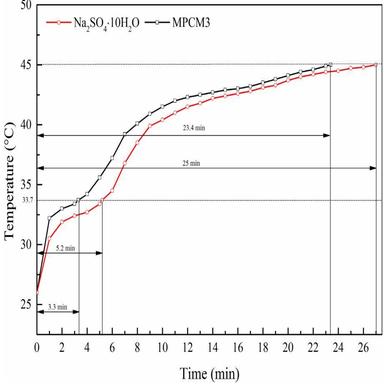
The temperature curves of the Na2SO4·10H2O and MPCM3 in melting process.